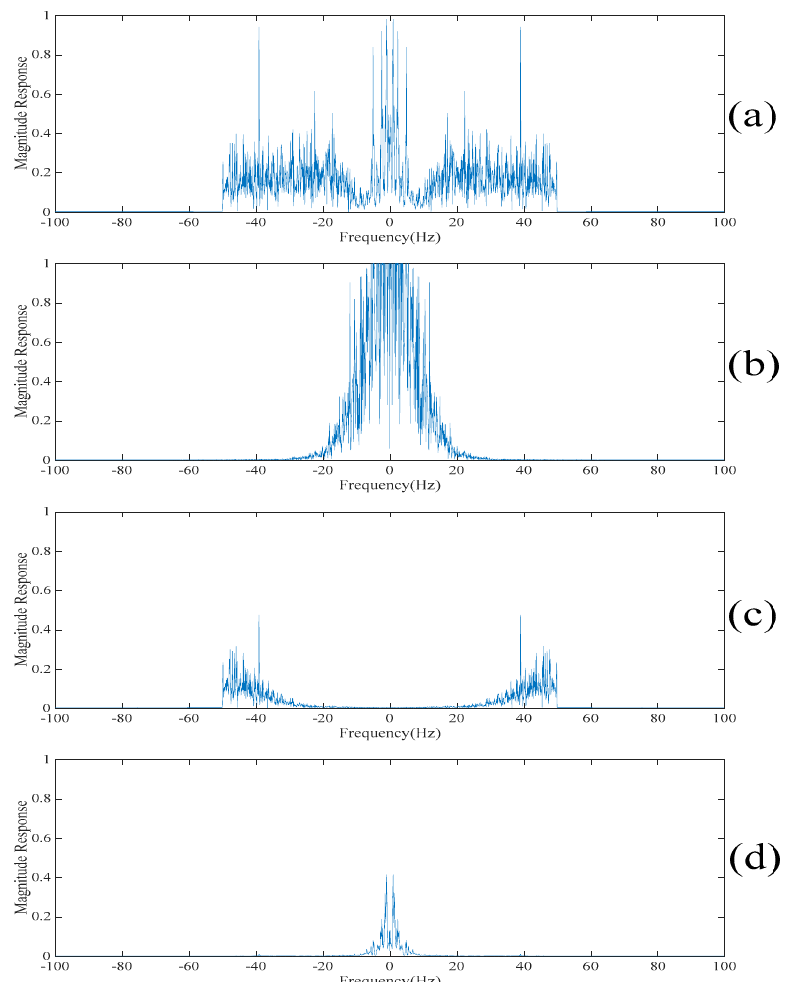
Figure 16. ( a ) The reconstructed electroencephalogram in the frequency domain obtained based on our proposed method. ( b ) The reconstructed electroencephalogram in the frequency domain obtained based on the conventional empirical mode decomposition-based method. ( c ) The reconstructed electroencephalogram in the frequency domain obtained based on the conventional singular spectrum analysis-based method. ( d ) The reconstructed electroencephalograms in the frequency domain obtained based on the conventional low-rank decomposition-based method.